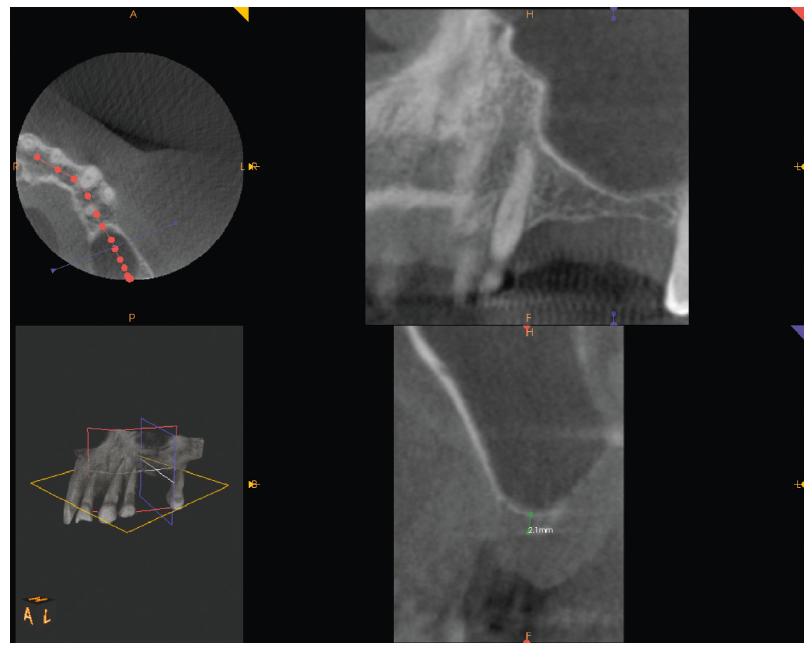
Figure 3: CT scan pre-op showing 2mm of Bbh at distal site.